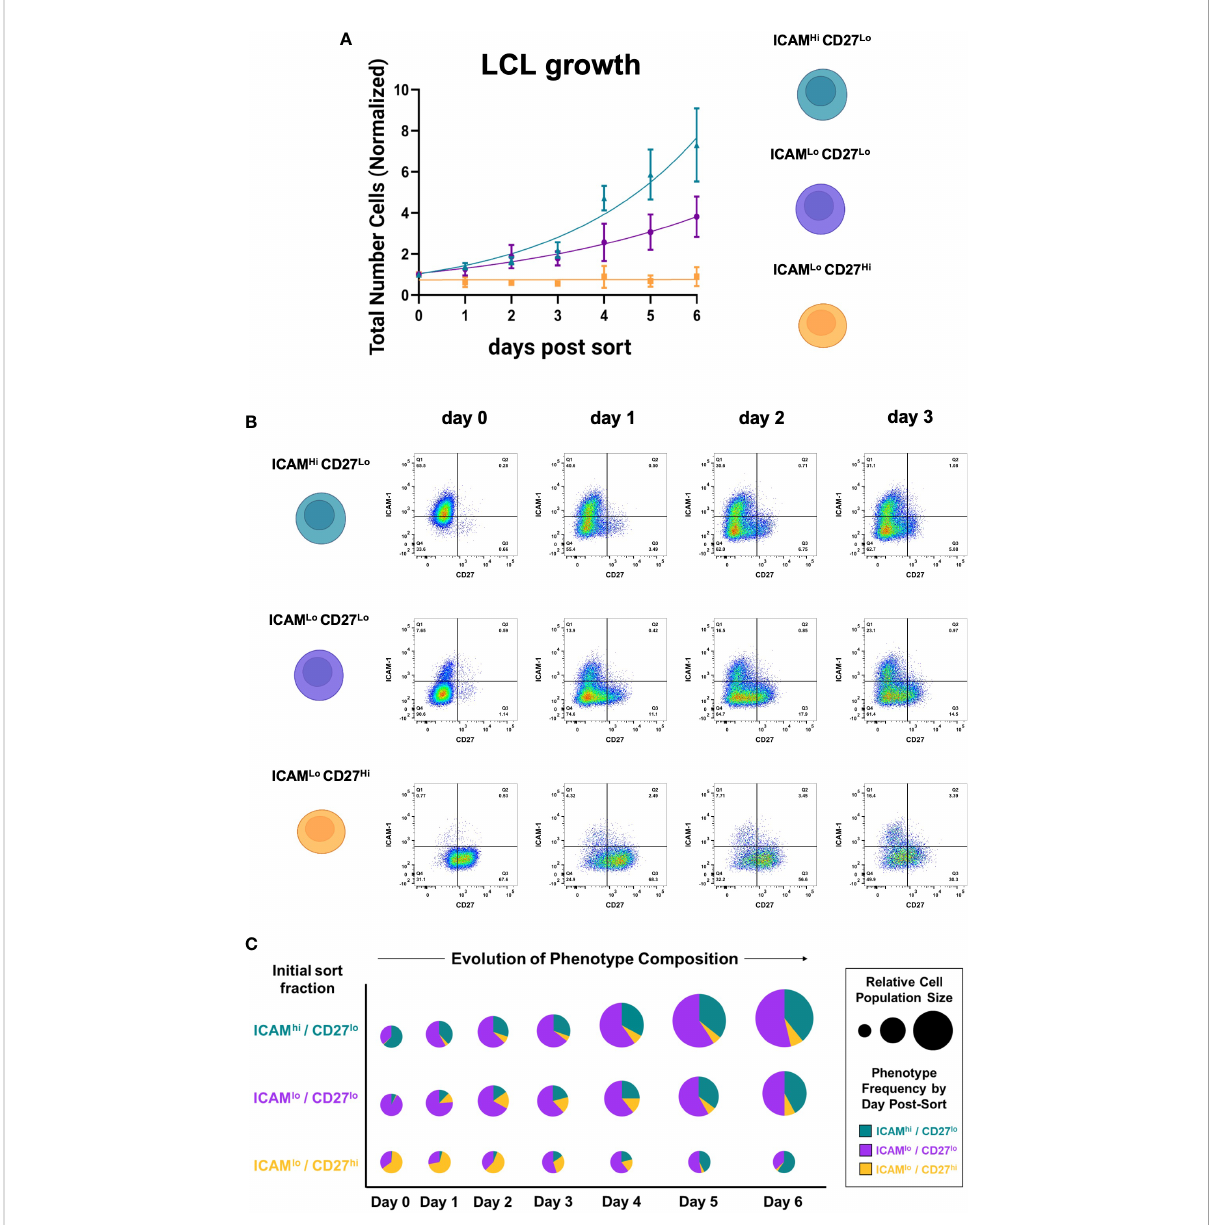
FIGURE 2 EBV + activated and differentiated cell fractions spontaneously recover parental LCL heterogeneity in culture. (A) Growth curves from ICAM-1 Hi / CD27 Lo , ICAM-1 Hi /CD27 Lo , and ICAM-1 Hi /CD27 Lo LCL fractions after sorting. Data from each day are presented as the mean number of cells normalized to initial population size at day 0 (error bars = standard deviation, n = 3 LCLs per fraction). (B) Representative time-resolved staining for ICAM-1 and CD27 in sorted fractions capture recovery of parental line phenotypic heterogeneity. (C) Fraction-resolved quanti fi cation of cell growth and phenotype distribution over six days in culture after